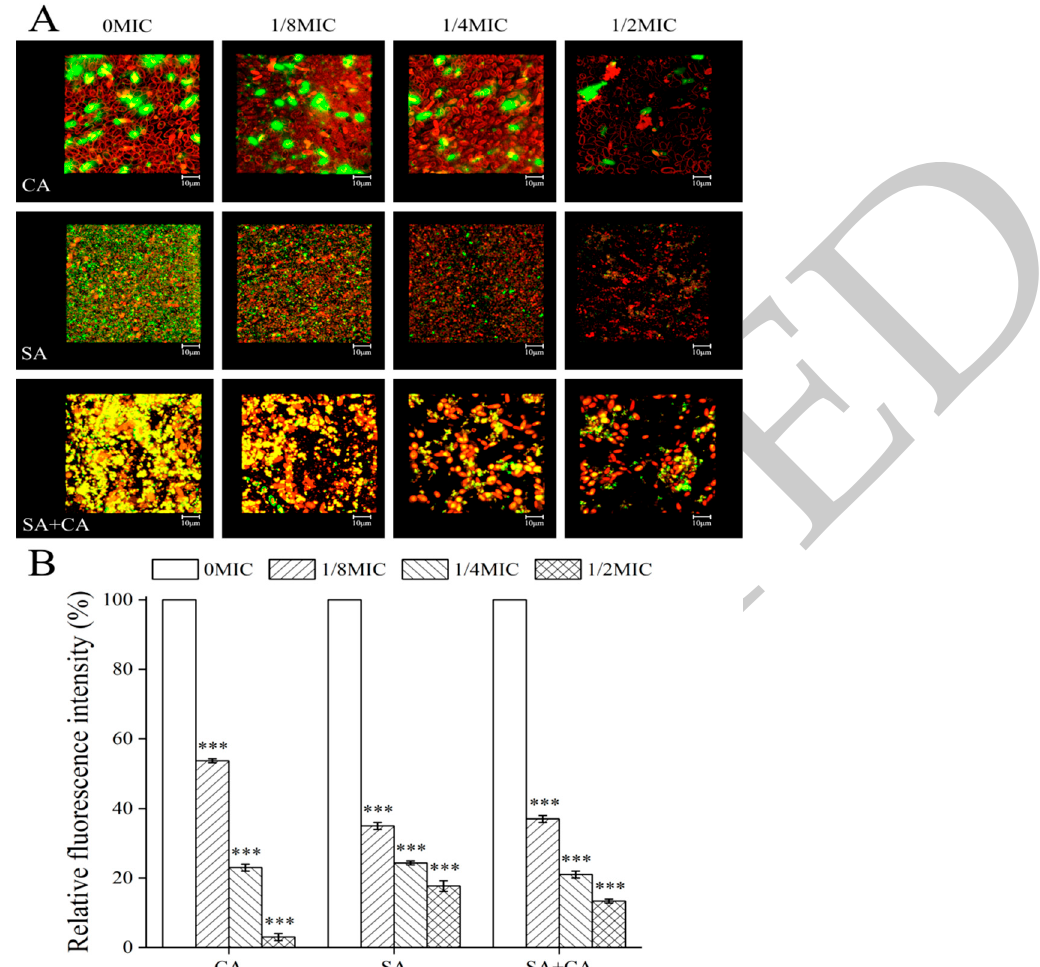
Figure 4. Investigation of the influence of sub-MIC sanguinarine on the levels of extracellular polysaccharides within C. albicans SC5314 (CA) and S. aureus CMCC26003 (SA) and dual-species (SA + CA) biofilms by confocal laser scanning microscopy. ( A ) Extracellular polysaccharides and microbial cells were labelled with a green fluorescent stain wheat germ agglutinin, and a red lipophilic membrane dye FM 4-64, respectively. Scale bars represent 10 µ m. ( B ) The relative fluorescence intensity of extracellular polysaccharides in biofilms of each treatment group was calculated and plotted against that in untreated group by measuring red / green fluorescence ratios using KS 400 version 3.0 software. Bars represent the standard deviation (N = 6). *** p < 0.001.